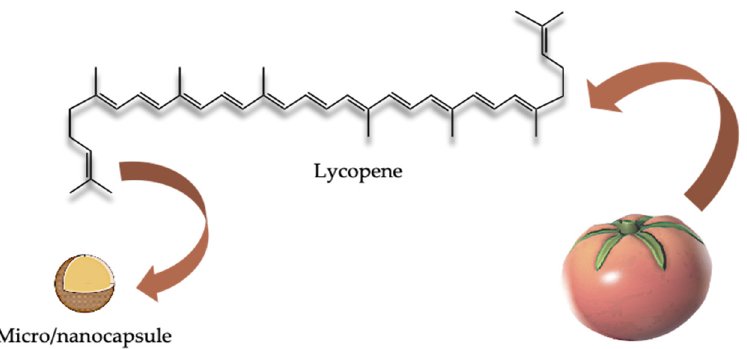
Figure 4. Microcapsules as delivery systems to improve the solubility and bioaccessibility of lyco- pene